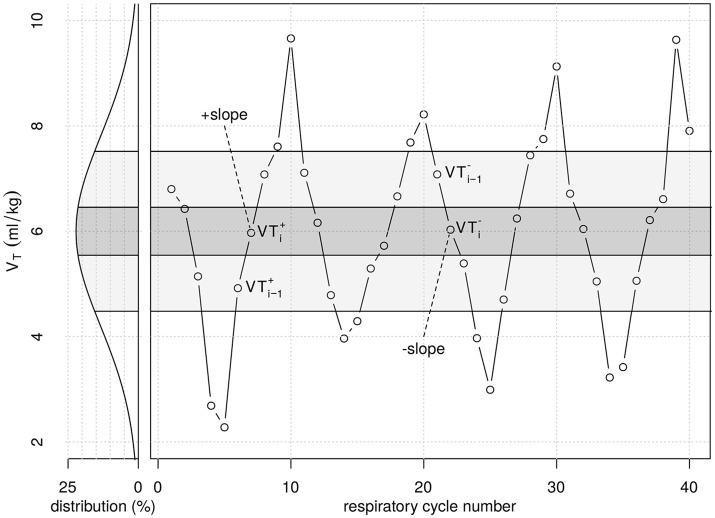
Graphical illustration of part of the tidal volume (VT) series from period pattern P10. Original VT values were randomly generated following a Gaussian distribution (white noise), with respective probability density (left). VT values were then taken from each of the five probability density regions shown (quintiles of the original random VT series) and re-ordered from lowest to highest (+slope) and highest to lowest (−slope) VT values, repetitively. VTi−1 represents VT in the second quintile during +slope, while VTi−1 represents VT in the fourth quintile during −slope. VTi+ and VTi− represent VT in the third quintile during−slope and +slope, respectively, which value is close to the mean of 6 mL/kg. The period pattern P04 was generated similarly, dividing the probability distribution curve into two density regions only.